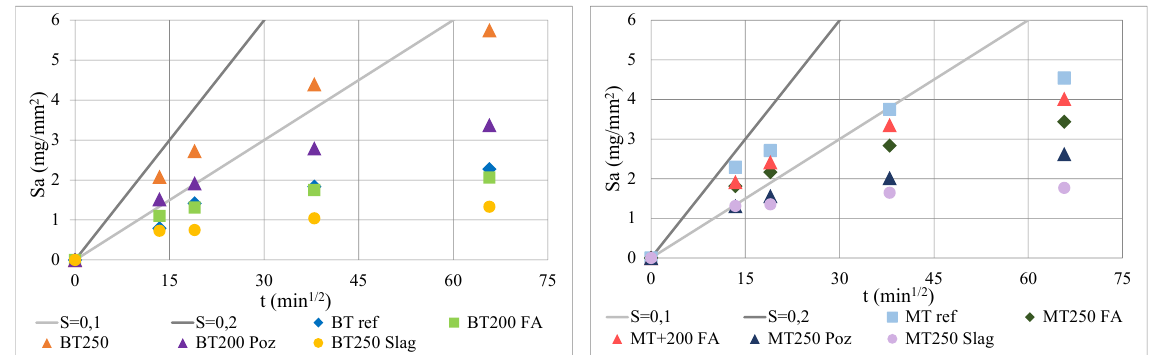
Figure 5. Capillarity water absorption through square root of time of BT (left) and MT(right) mixtures.